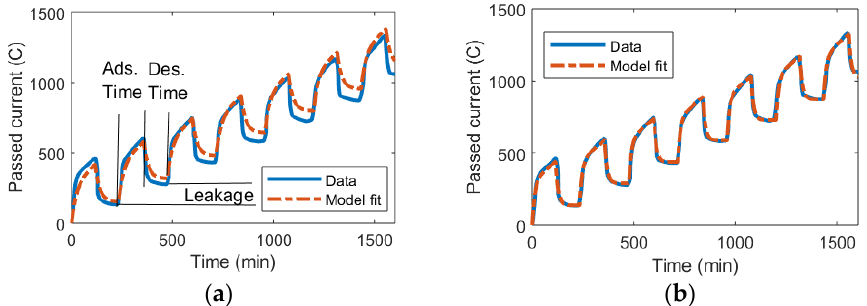
Figure 6. The total accumulated current passed through a CDI device over multiple cycles of adsorption at 0.9 V and desorption with no applied voltage. Data from [70]. Note that the difference between the adsorbed and released charge constitutes the leakage. ( a ) The circuit model was implemented using classic parameter extraction as derived in the theory section. ( b ) The circuit model was implemented using a nlgreyest system identification method in MATLAB for parameter extraction (program code in Supplementary S1).